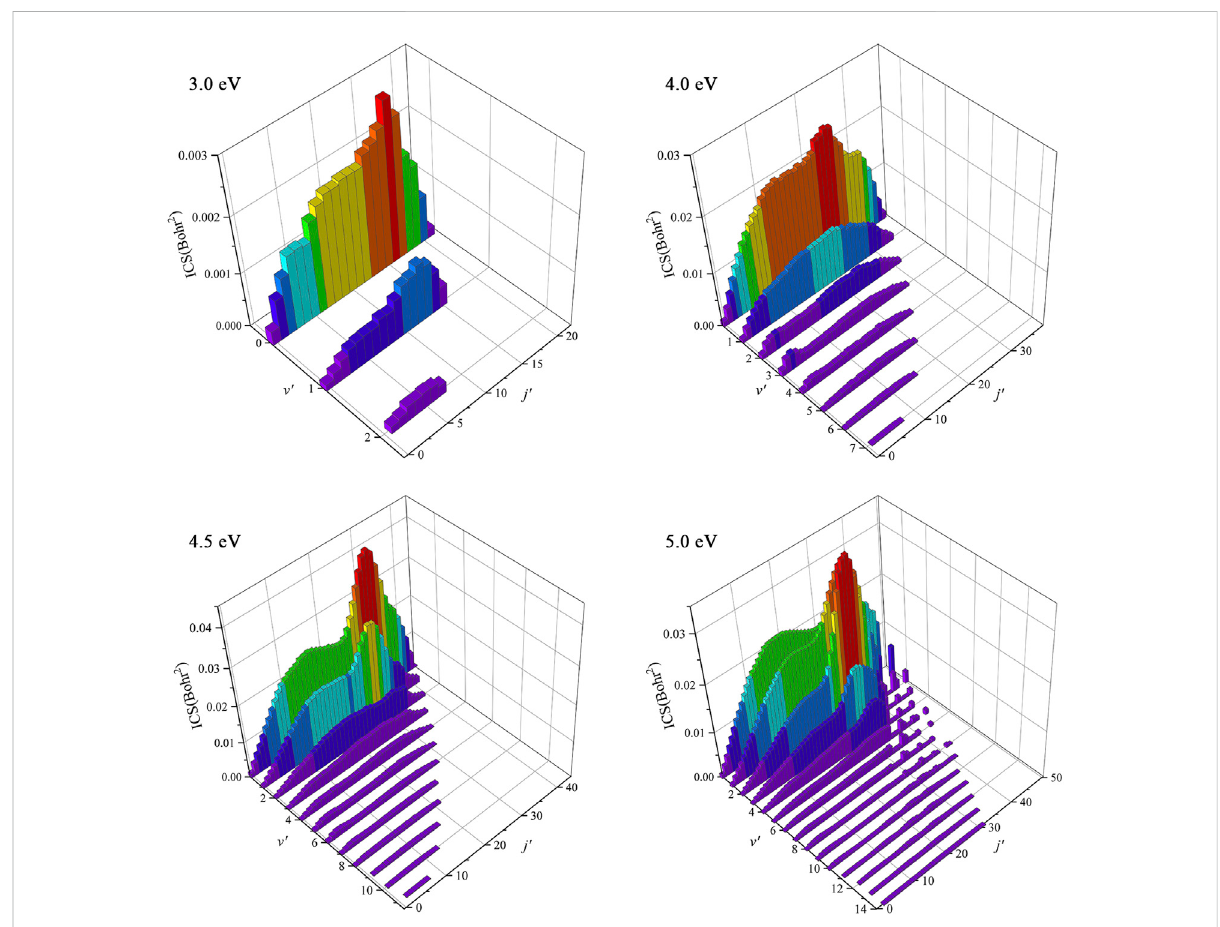
FIGURE 8 Rovibrationally state-resolved ICSs of the Be( 1 S) + H 2 ( v 0 = 0, j 0 = 0) → BeH + H reaction at four collision energies (3.0, 4.0, 4.5, and 5.0 eV) calculated by the TDWP method on the ground-state BeH 2